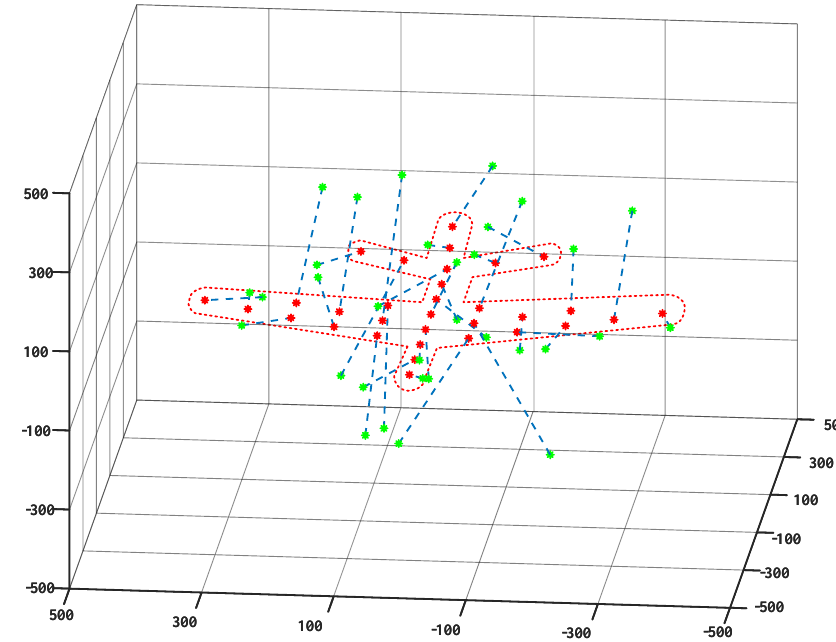
Figure 4. The side perspective of topology shaping in aircraft